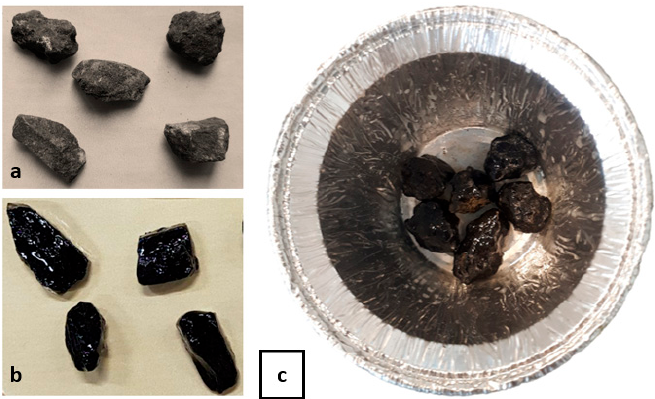
Figure 2. Original, untreated Reclaimed Asphalt (RA) granulates ( a ); RA granulates mixed with neat bitumen ( b ); RA granulates sprayed with rejuvenator ( c